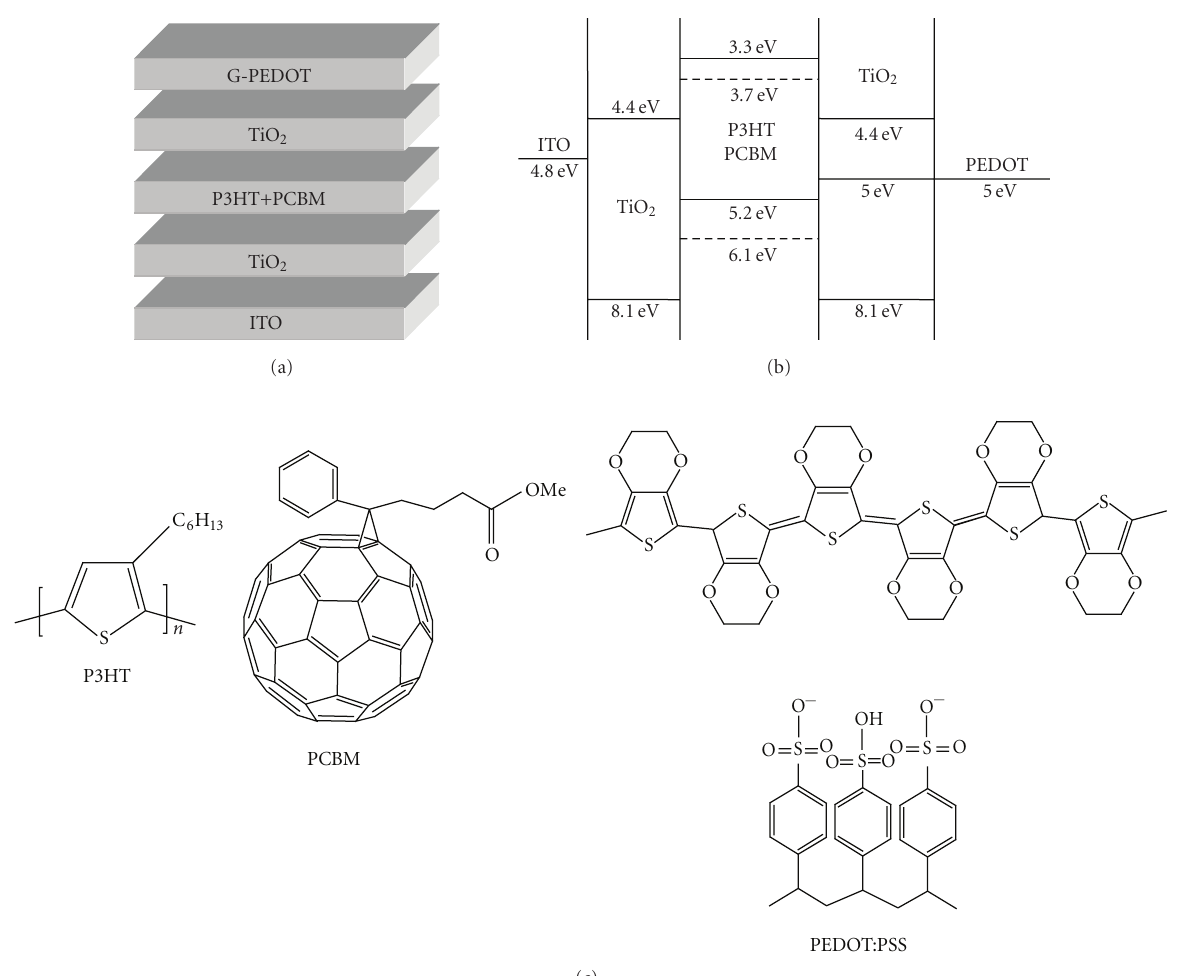
Figure 1: (a) The device structures of the solution processed photovoltaic cell. (b) The energy levels of the single components of photovoltaic cell. (c) Molecular structures of the active materials and conductive polymer: P3HT, PCBM, PEDOT:PSS.